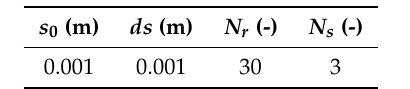
Table 5. RBS (Resistor-Based Sensors) parameters for the simulations.